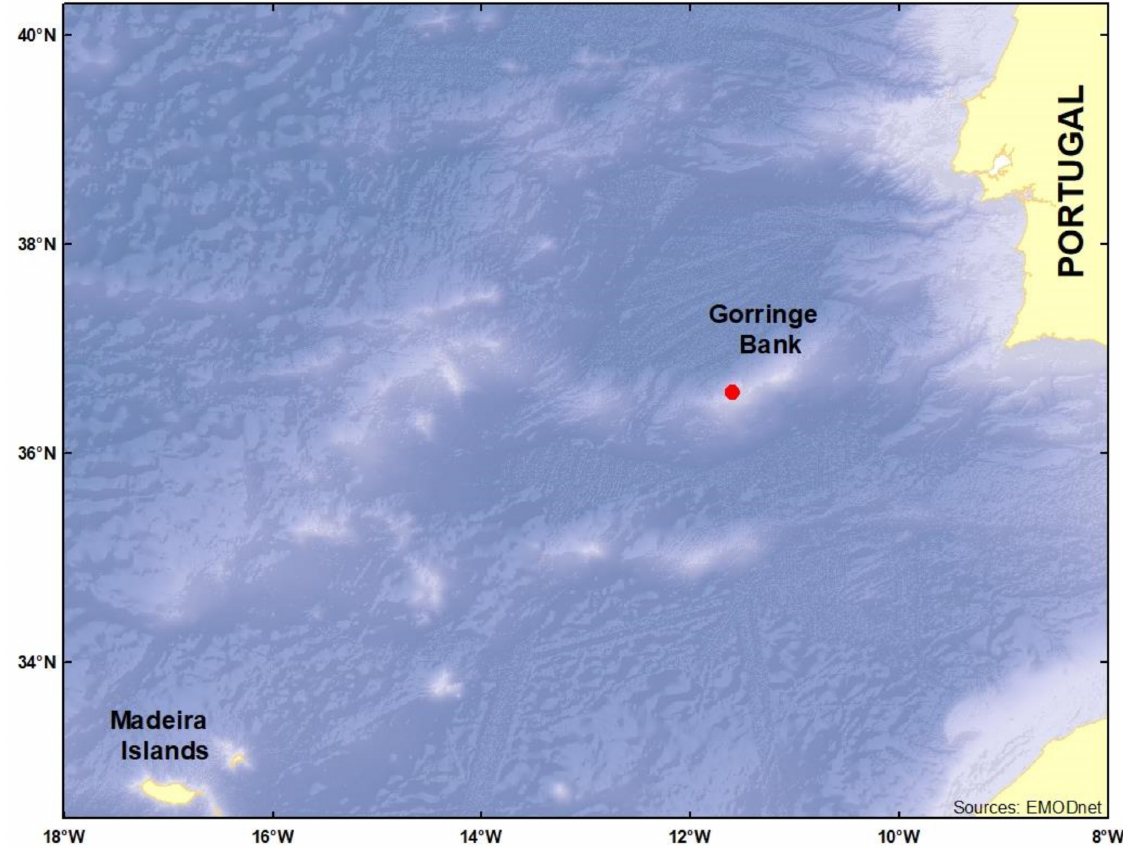
Fig. 1. Map showing the location of the sampling site (red